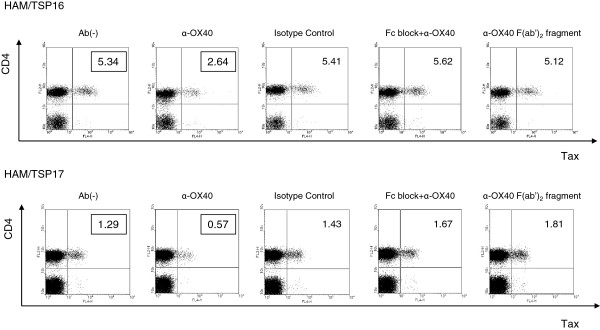
Expression of OX40 in inflammatory mononuclear cells in spinal cord lesions of HAM/TSP patient with short disease duration and progressive symptoms. We studied autopsy specimens from 9 HAM/TSP patients by immunohistochemical staining. A. No OX40 positive cells are detected in the spinal cord lesion without active inflammation of a HAM/TSP patient with a long duration of illness. Magnification: ×40. B. Many infiltrating mononuclear cells are positively stained by anti-OX40 mAb in the spinal cord lesion with active inflammation of HAM/TSP patient with 2.5 years of illness. Magnification: ×40. C. There was reduced or no OX40L protein expression in spinal cord tissues of HAM/TSP patients. OX40L showed only low background staining and there was no OX40L positive staining on inflammatory mononuclear cells in the spinal cord lesions. Magnification: ×20. D. Positive control staining for OX40L positive CEM-OX40L cells. Magnification: ×20. Bar: 50 μm.